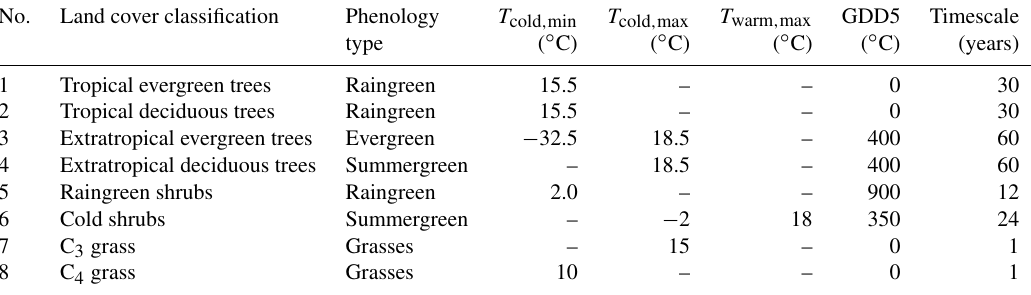
Table 1. Bioclimatic limits and timescale of allocation and mortality for the eight natural plant functional types (PFTs) used in the dynamic vegetation module of the model JSBACH. Listed are phenology type, PFT-specific minimum ( T cold , min ) and maximum ( T cold , max ) of the mean temperature of the coldest month, PFT-specific maximum mean temperature ( T warm , max ) of the warmest month and growing degree days, i.e. temperature sum of days with temperatures exceeding 5 ◦ C (GDD5). All temperature values are given in ◦ C.